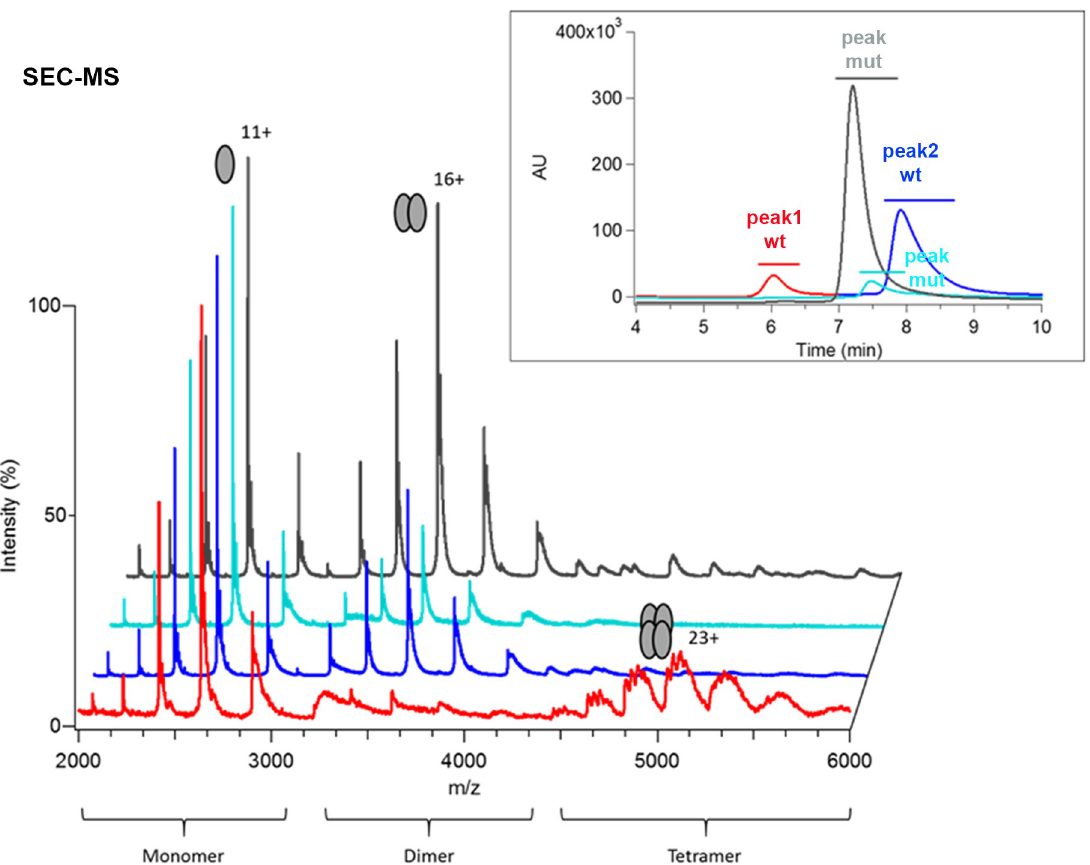
Fig 5. Oligomeric status of wild-type (wt) RXR α LBD and mutants, where the conserved Glu residue of the π -turn motif is mutated to Ala (E352A) or deleted ( Δ E352). Size-exclusion chromatography (SEC)-coupled native mass spectrometric analysis for wt RXR α LBD (red for the first peak and blue for the second peak), E352A RXR α LBD (cyan) and Δ E352 RXR α LBD (grey). The insert depicts the size- exclusion chromatograms of wt RXR α LBD and of mutants RXR α LBD (with the same color code). The region of the SEC peak considered for the integration of the mass spectra is shown as a line above the SEC peak. For wt RXR α LBD the tetrameric species is seen at the beginning (I) of the SEC chromatogram. In contrast, monomeric species is observed for all SEC peaks together with dimeric species. For mutant RXR α LBD species, no tetramer is observed in the SEC chromatogram and in the corresponding mass spectra where mainly monomeric and dimeric species are observed.